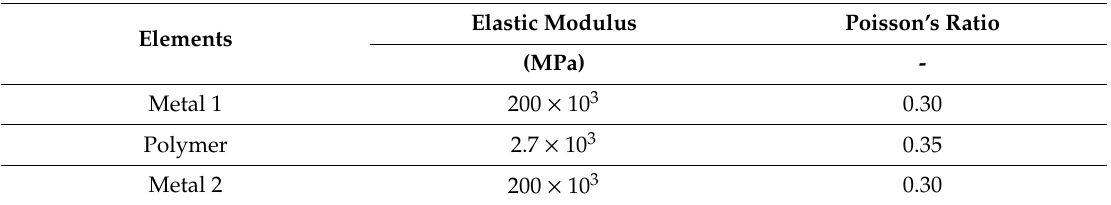
Table 3. Material constants of the metal elements and the polymer one (steel material data from the ANSYS library, polymer material data from own research).